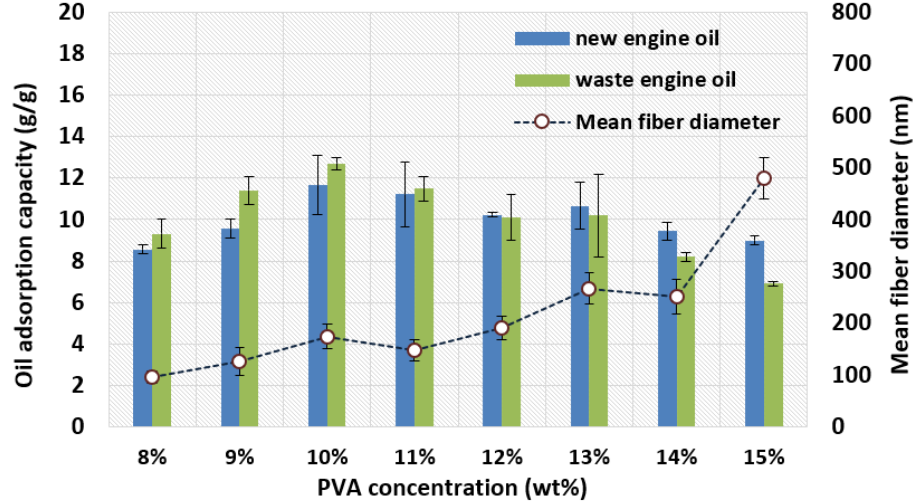
Figure 8. Oil adsorption capacities for various PVA membranes.